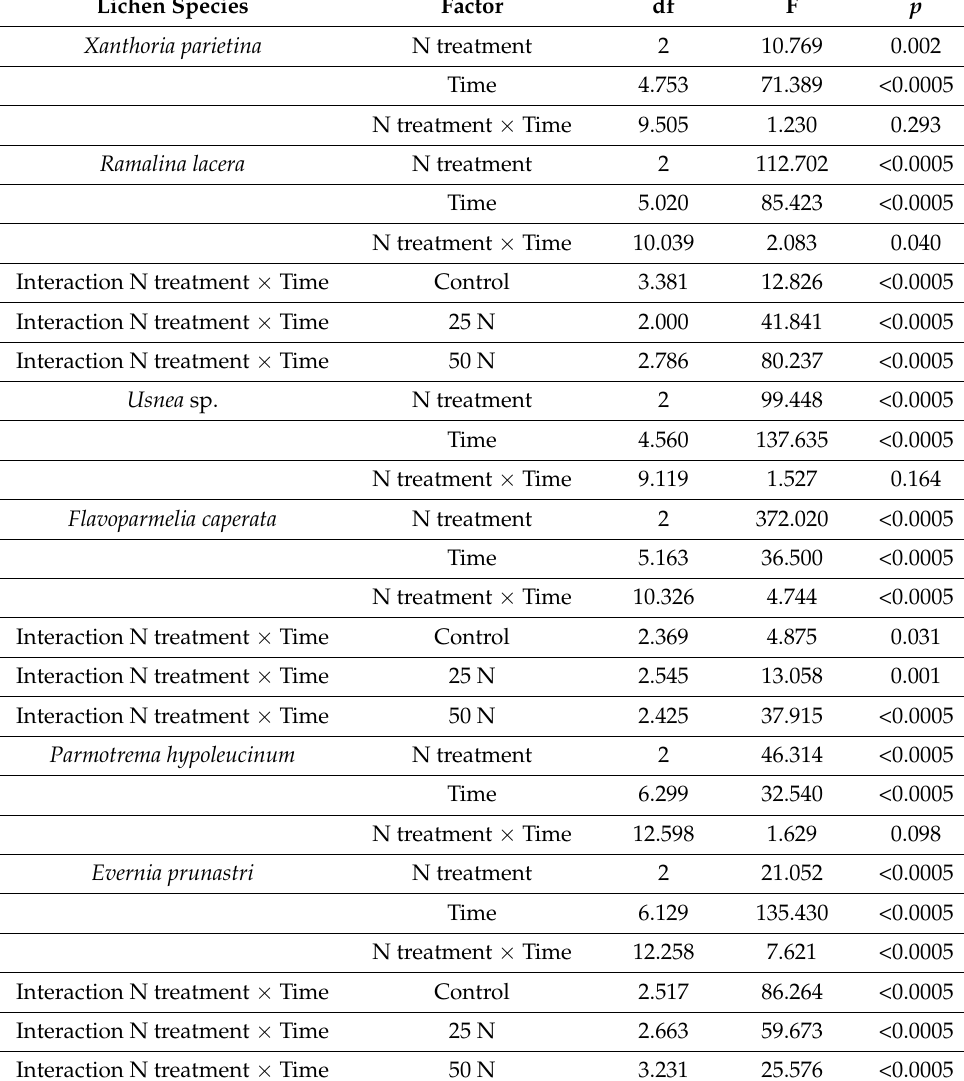
Table 3. Repeated measures ANOVA analyses for all the studied epiphytic lichens during the whole experiment. The samples were subjected to N treatment and solar radiation. Control = No nitrogen (N) addition, 25 N = treated with 25 mM of (NH 4 ) 2 SO 4 , 50 N = treated with 50 mM of (NH 4 ) 2 SO 4